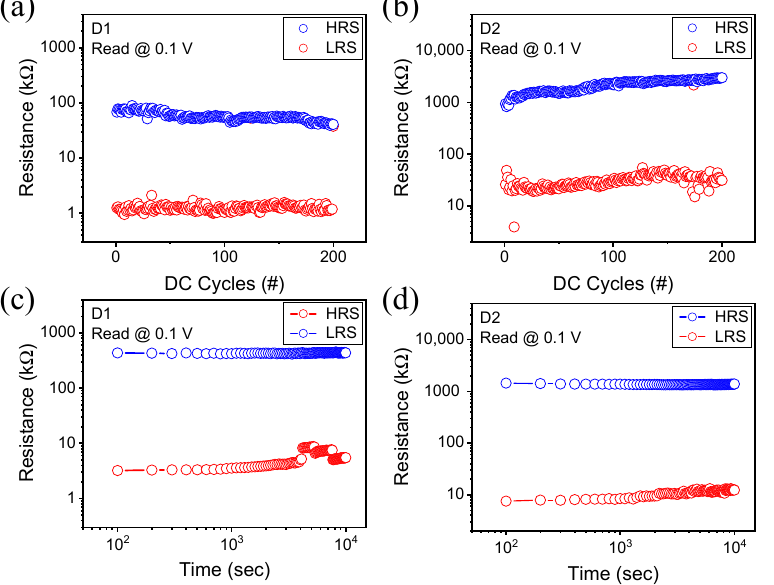
Figure 3. Endurance in ( a ) the D1 device and ( b ) the D2 device measured through the repetitive DC voltage application. Retention in ( c ) the D1 device and ( d ) the D2 device measured at room temperature for 10 4 s.